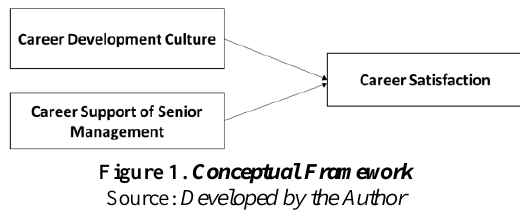
Figure 1. Conceptual